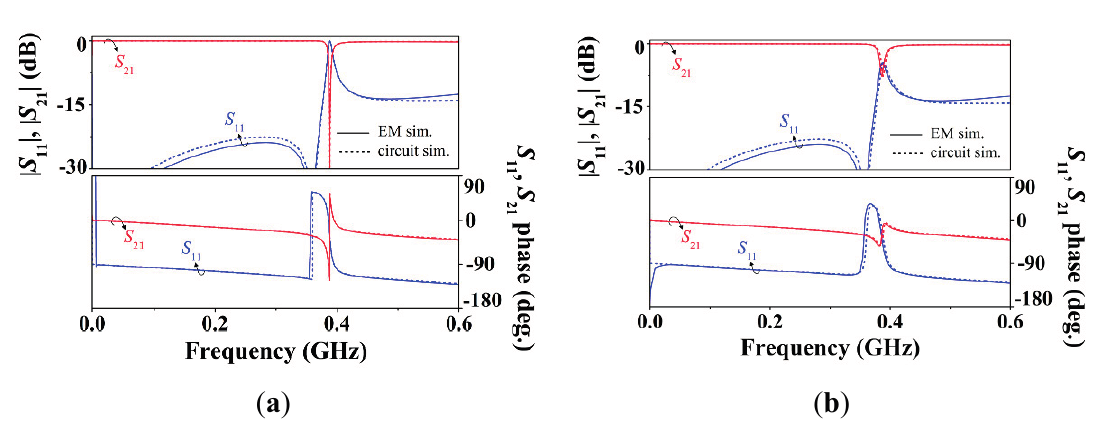
Figure 7. Frequency response of the S-SRR-loaded line of Figure 6b for 90° orientation obtained by ( a ) lossless and ( b ) lossy electromagnetic and circuit simulations. The circuit elements are indicated in Table 1. Despite its frequency dependence, a constant value resistance computed at the resonance frequency is assumed ( R s = k s ω 0 s 1/2